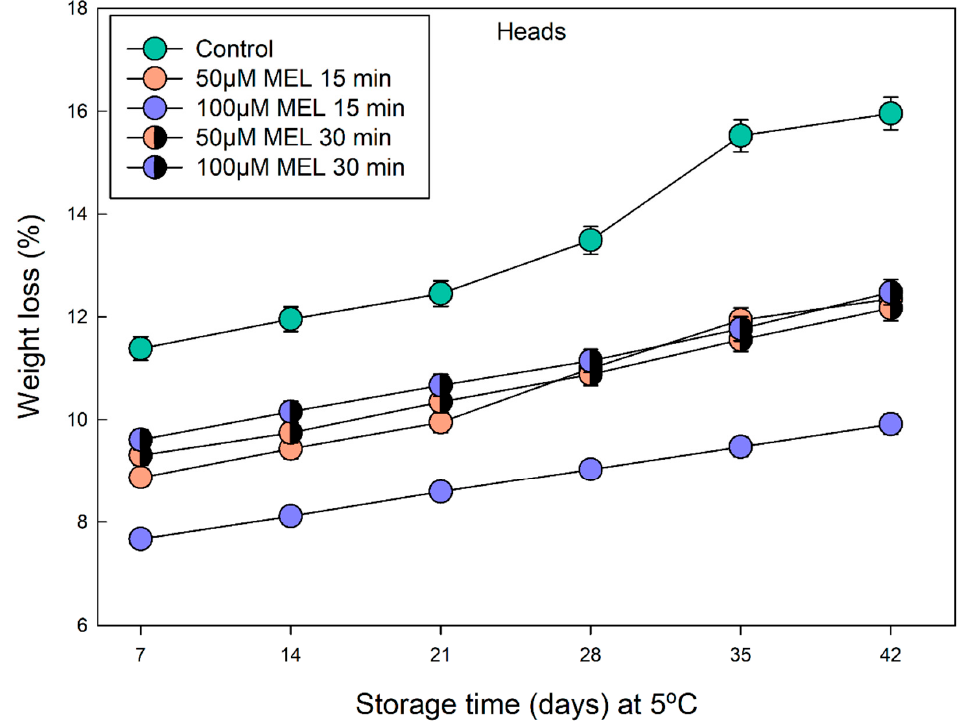
Figure 3. Weight loss of broccoli heads treated with 50 and 100 μ M of melatonin during 15 and 30 min and stored in the dark at 5 °C for 0, 7, 14, 21, 28, 35 and 42 days. Each point represents the mean value and ± standard error ( n = 3) obtained for each concentration used.